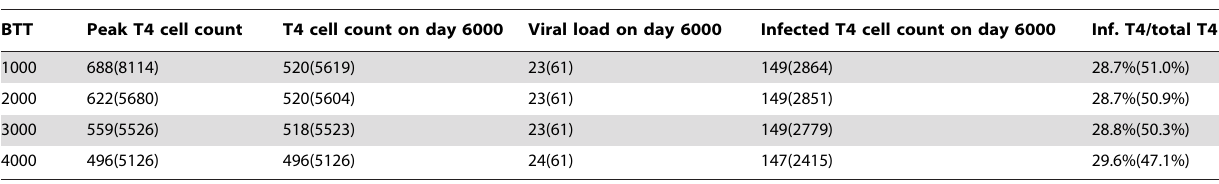
Table 5. Simulation of different